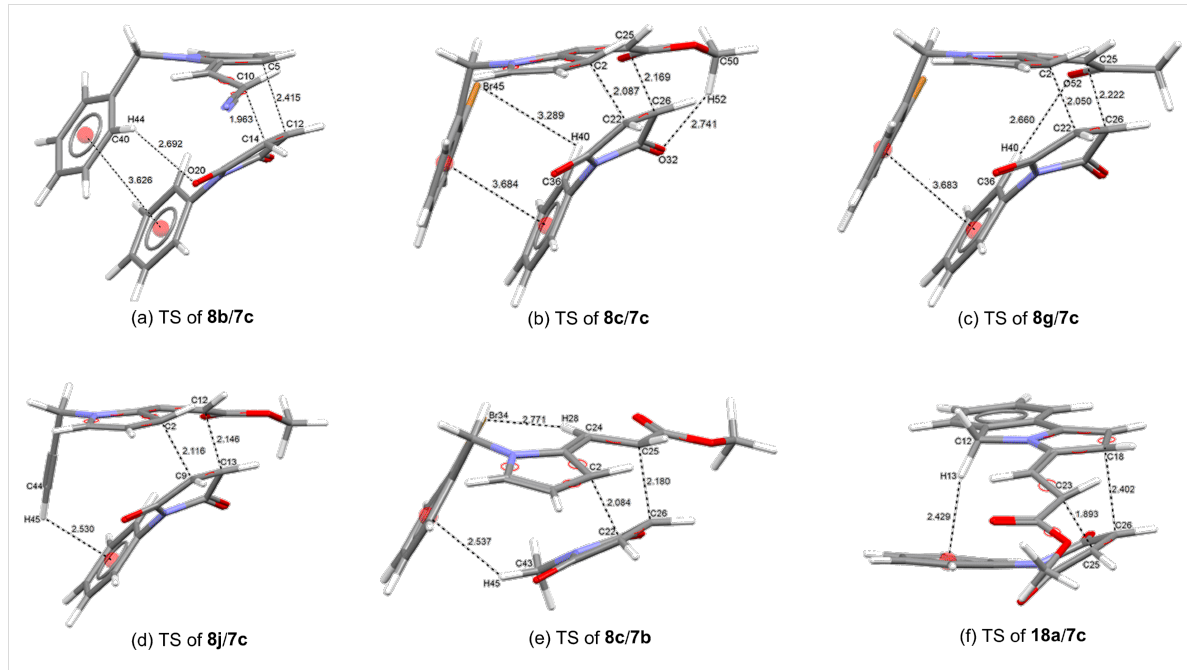
Figure 4: M06-2X/6-31+G(d,p) Optimized geometry for each of the TSs of the Diels–Alder reactions of dienes 8b , 8c , 8g , 8j and 18a with dienophiles 7b , c for the endo approach, showing the π ··· π , C–H··· π , C–H···OC and C–H···Br stacking interactions and their distances